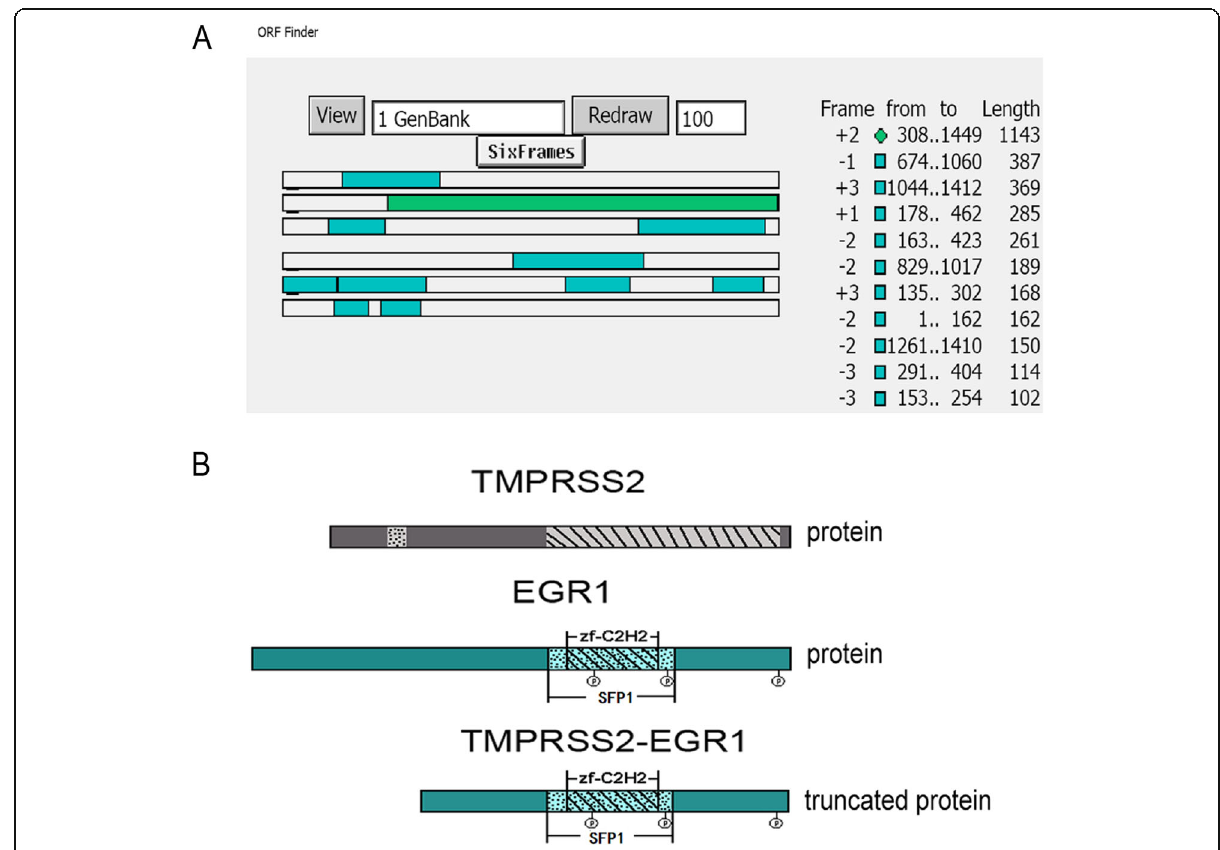
Fig. 3 Structure of putative truncated protein coded by TMPRSS2-EGR1 hybrid transcript. a The coding sequence predicted by NCBI ORF Finder. The highest rank of the open reading frame is + 2 frame shown in green. b The schematic structure of TMPRSS2(NP_005647.3), EGR1 (NP_001955.1) protein, and the putative truncated protein coded by their hybrid mRNA. The predicted structure contains SPF1, zf-C2H2 domain, and all three phosphorylation